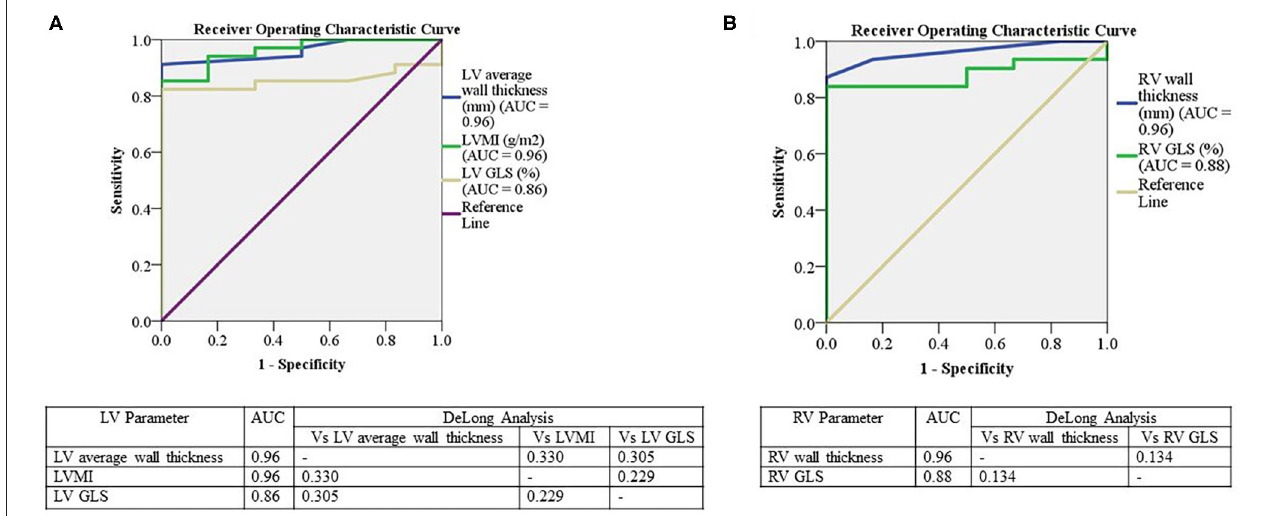
FIGURE 5 | Receiver operator curves for the relationship between LV and RV parameters to 99m Tc-DPD uptake. Receiver operator curves for the relationship between LV 99m Tc-DPD uptake with LV average wall thickness, LVMI and LV GLS (A) and RV 99m Tc-DPD uptake with RV wall thickness and RV GLS (B) . Significant if p < 0.05. LV, Left ventricle; AUC, area under the curve; LVMI, left ventricular indexed mass; GLS, global longitudinal strain; RV, Right ventricle; Vs, Versus; 99m Tc-DPD, Technetium-99m 3,3-diphosphono-1,2-propanodicarboxylic acid.